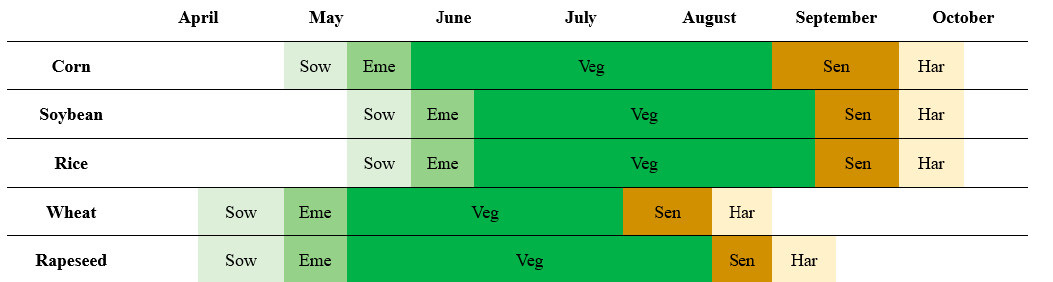
Figure 2. Phenological stages of main crop types in the study area. The background colors are indicative of field colors at different stages. (Note: Sow = Sowing stage, Eme = Emergence stage, Veg = Vegetative period, Sen = Senescence stage, Har = Harvesting stage.).